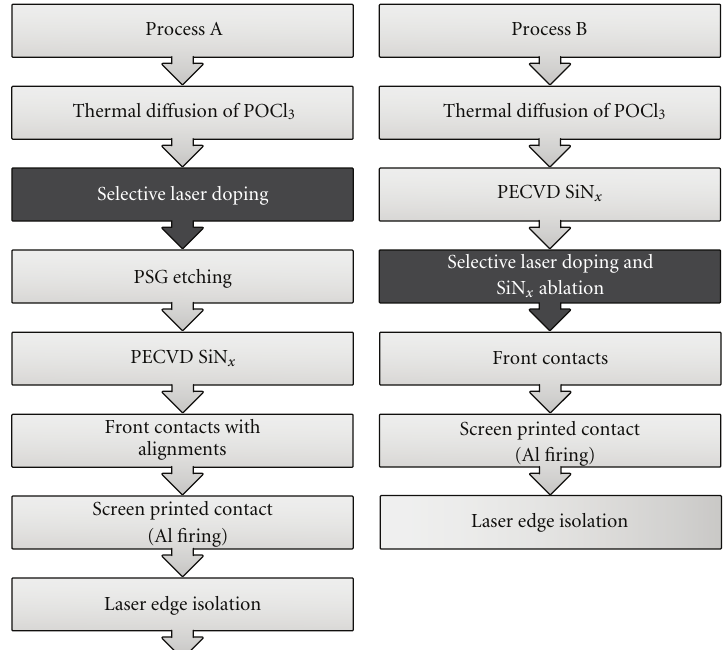
Figure 1: Processes for selective emitter solar cells with (Process A) and without (Process B) chemical etching and alignment steps.